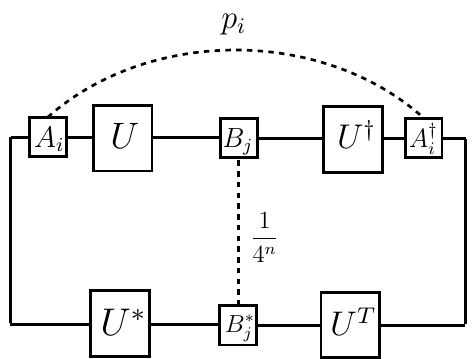
Figure 7 . A graphical depiction of eq. (F.9) equal to the probability that Alice did not apply a perturbation, p i = p I for A i = I . Starting from the top left and reading clockwise, we see that this corresponds to an average over all choices of A i ; B j of 4-point OTO correlators of the form ~ B y A i ~ B j A y . Note that the average over A i is with probabilities p i , but the average over B j is i j i h uniform with probabilities p j = 2 (cid:0) 2 n